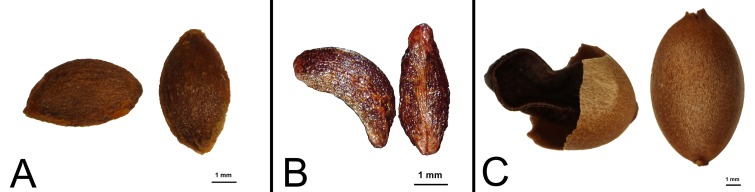
Seed type of Celastrus in China.3-6-seeded fruit with ellipsoid seed (A, without aril), 3-6-seeded fruit with lunate seed (B, without aril) and 1-seeded fruit with ellipsoid seed (C, covered by dry aril).